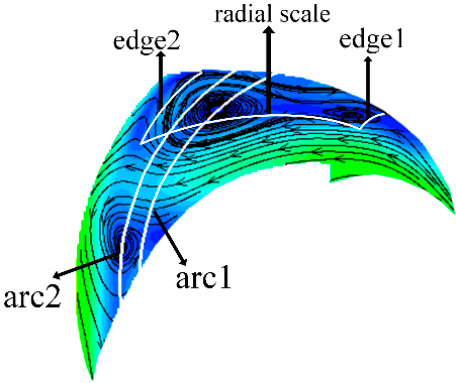
Figure 5. Radial scale of the vortex and the arc that through the vortex center.